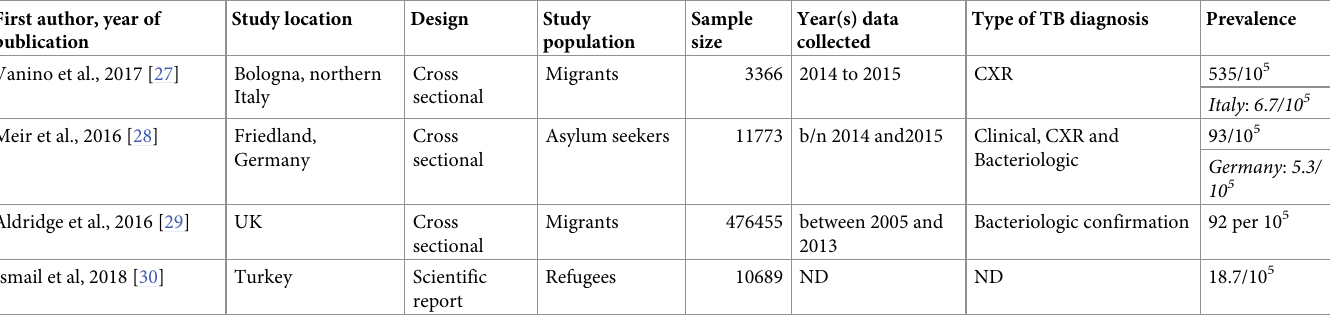
Table 2. Study characteristics and TB prevalence results among the included